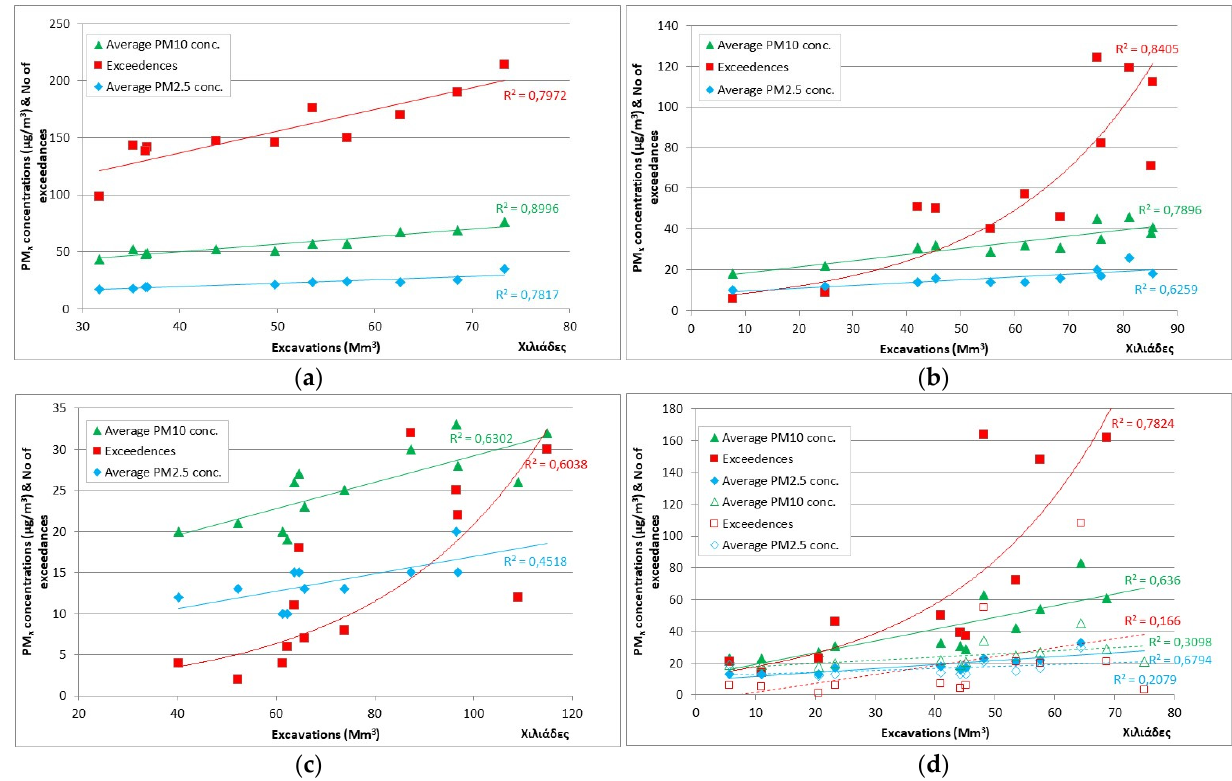
Figure 2. Correlation of the average PM10 and PM2.5 concentrations and number of exceedances of the daily average PM10 concentrations from the limit value of 50 μ g/m 3 , as recorded in monitoring stations (MS) located in the vicinity of the mines, with the total annual rock excavations in four different lignite mining fields of Ptolemaida basin: ( a ) Main Field vs. Proastio MS; ( b ) Kardia Field vs. Pontokomi MS; ( c ) South Field vs. Kilada MS; ( d ) Amynteo mine vs. Anargiri MS (solid line) and Amynteo MS (dashed line).